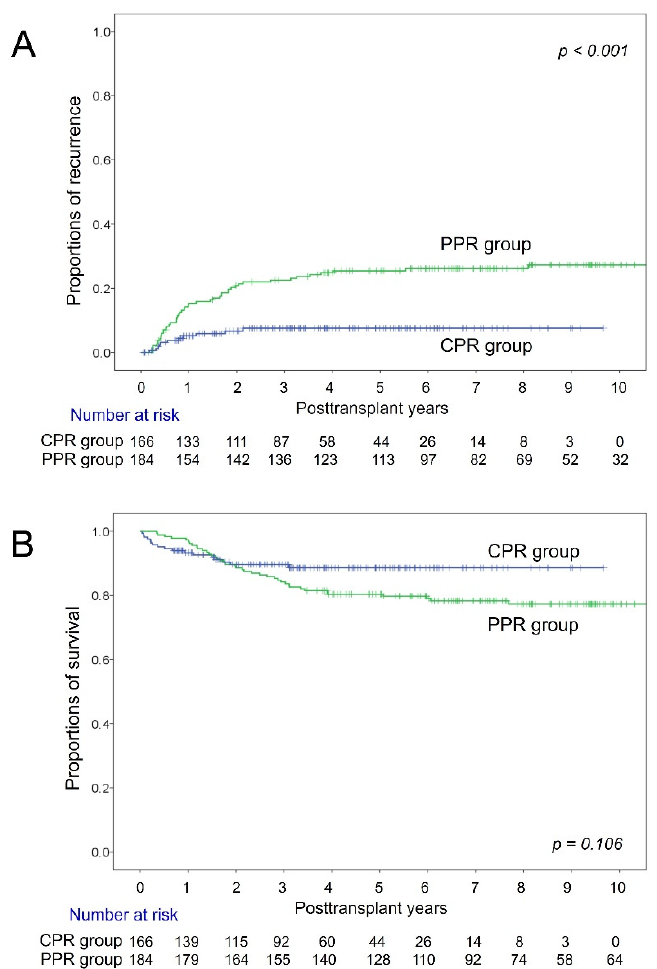
Figure 5. Kaplan-Meier curves of tumor recurrence ( A ) and overall patient survival ( B ) in liver transplant recipients showing hepatocellular carcinoma with the complete pathological response (CPR) and partial pathological response (PPR).